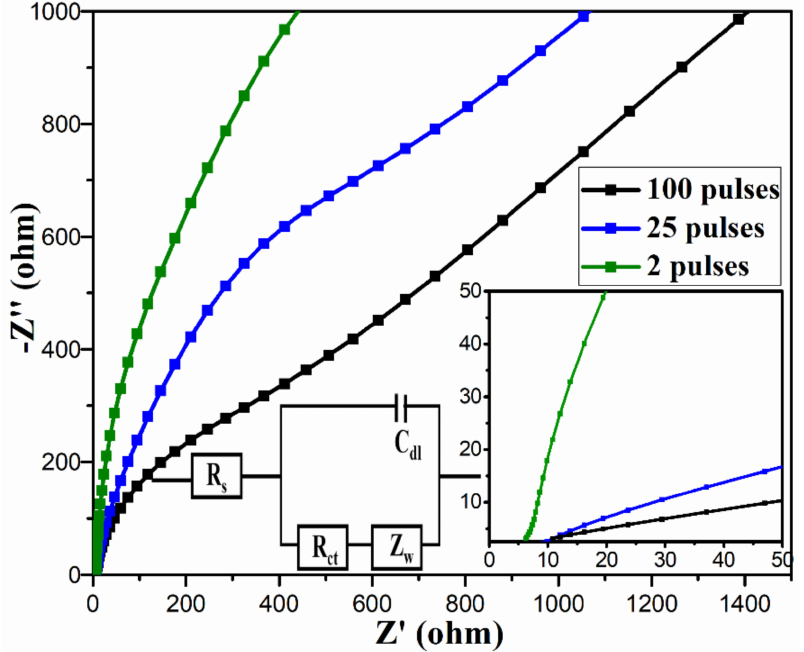
Figure 9. Nyquist plots for all the samples, the insets show a zoom-in of Nyquist plots at high frequency region, and the equivalent